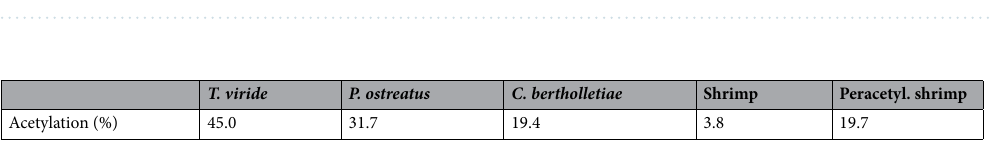
Figure 2. Detail of solution 1 H NMR spectra shown in Supplementary Fig. S4. Red lines and numbers represent integrals for both chain protons (between 3.2 and 4.2 ppm, normalized at 100.0) and methylic protons of the acetyl groups (at ~ 2.0 ppm).